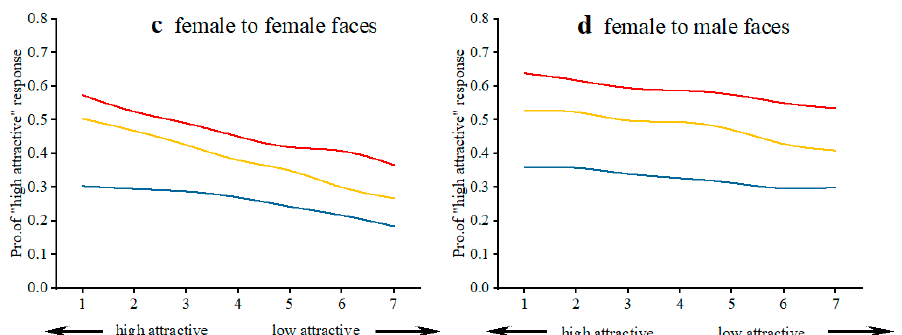
Figure 5. Effect of gender and odor valence on facial attractiveness. Gender consistency induced attractiveness biases along the valence dimension: male participants viewing female faces ( a ); male participants viewing male faces ( b ); female participants viewing female faces ( c ); female participants viewing male faces ( d ).